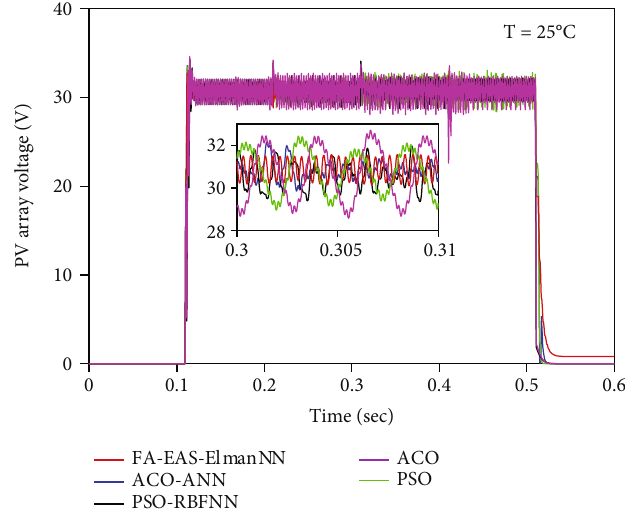
Figure 14: Voltage waveform of PV array under rapidly changing G .